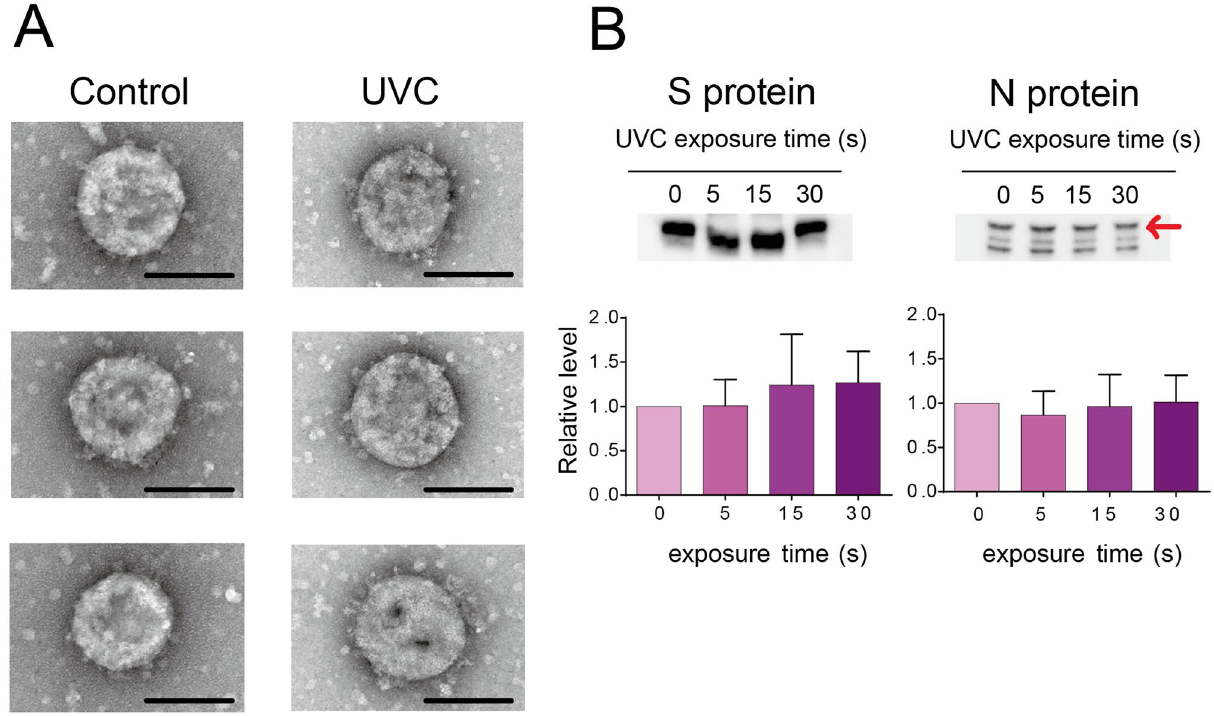
Figure 3. Effect of ultraviolet C (UVC) irradiation on viral morphology and viral proteins. ( A) Representative viral particle images analyzed by transmission electron microscopy (TEM, three pictures for each group). SARS- CoV-2 (1 mL) with a titer of 1.78 × 10 6 50% tissue culture infective dose (TCID 50 /mL) was irradiated with a UVC light tube for 60 s and then analyzed by TEM (Scale bar of 100 nm). ( B) Representative immunoblot images of viral spike (S) and nucleocapsid (N) proteins. SARS-CoV-2 (1 mL) with a titer of 1.78 × 10 6 TCID 50 /mL was irradiated with a UVC light tube for increasing periods of time from 0 to 30 s. Equal volumes of irradiated virus suspension were then used for immunoblotting analysis using anti-SARS-CoV-2 spike monoclonal antibody (1A9) and anti-SARS-CoV-2 nucleocapsid monoclonal antibody (6H3) (upper panel). Positions of the S and N proteins are indicated. Full-length blots are shown in Supplementary Fig. S1. The intensity of both proteins is analyzed using CS Analyzer 4 software and quantitative results are shown in the bar diagram (lower panel). Data in the plot represent the mean ± standard deviation (SD) of three replicates. Significance has been determined using one-way analysis of variance followed by Dunnett’s multiple comparisons